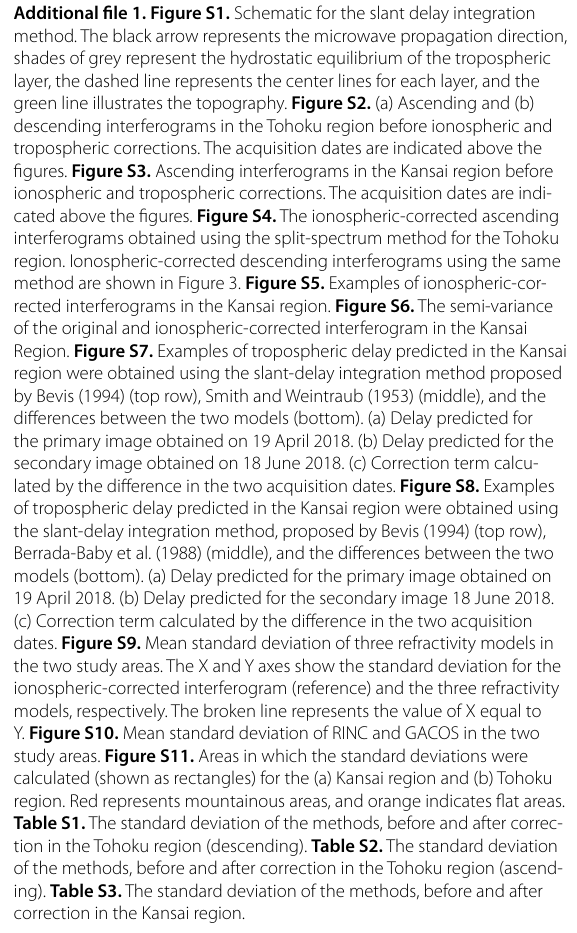
Y. Figure S10. Mean standard deviation of RINC and GACOS in the two study areas. Figure S11. Areas in which the standard deviations were calculated (shown as rectangles) for the (a) Kansai region and (b) Tohoku region. Red represents mountainous areas, and orange indicates flat areas. Table S1. The standard deviation of the methods, before and after correc- tion in the Tohoku region (descending). Table S2. The standard deviation of the methods, before and after correction in the Tohoku region (ascend- ing). Table S3. The standard deviation of the methods, before and after correction in the Kansai